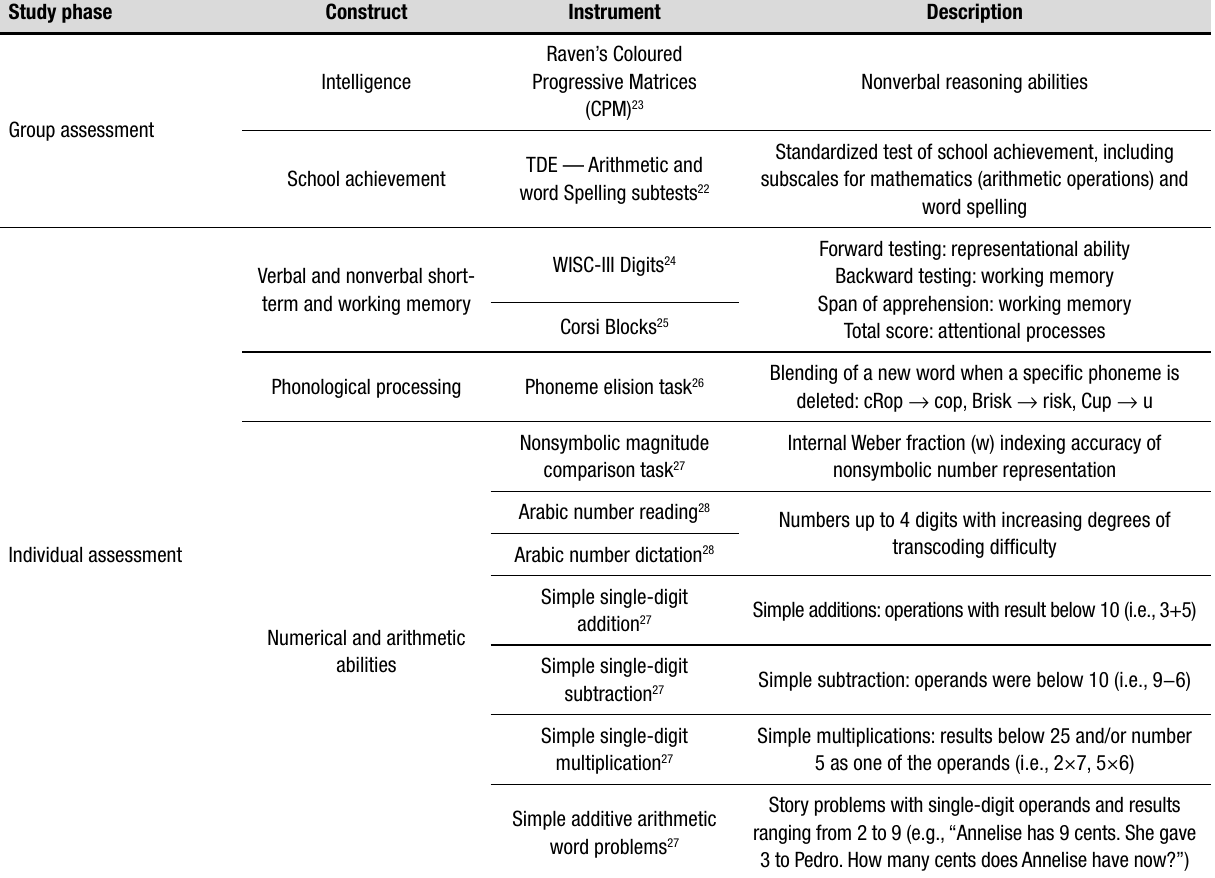
Table 2. Instruments used in the neuropsychological